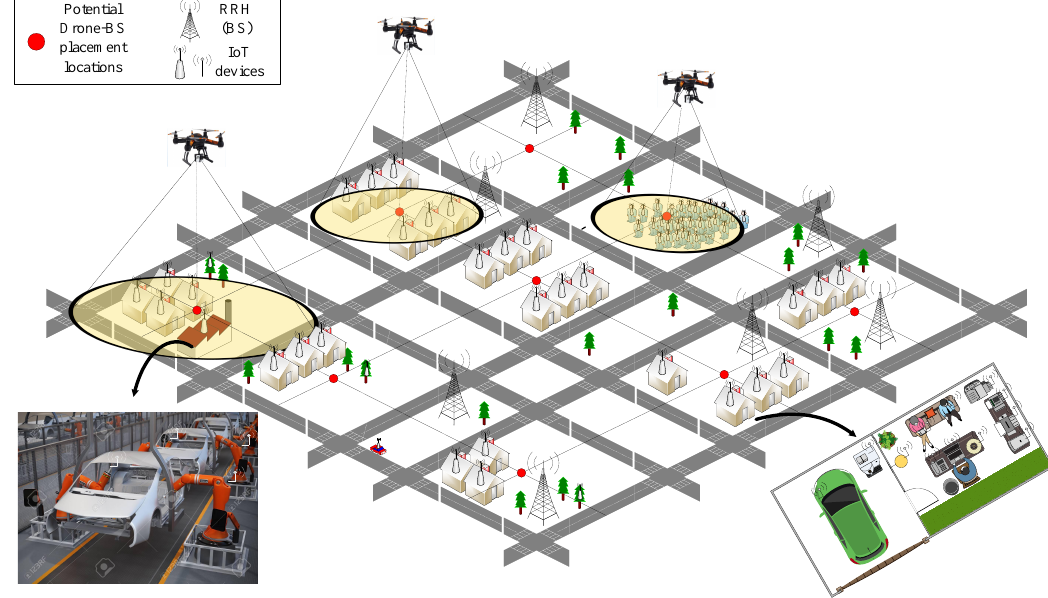
Figure 1. Proposed system model of an Internet of Things (IoT) network spread. It consists of N heterogeneous IoT (mobile and stationary) users spread over a metropolitan area with M potential locations for DBS